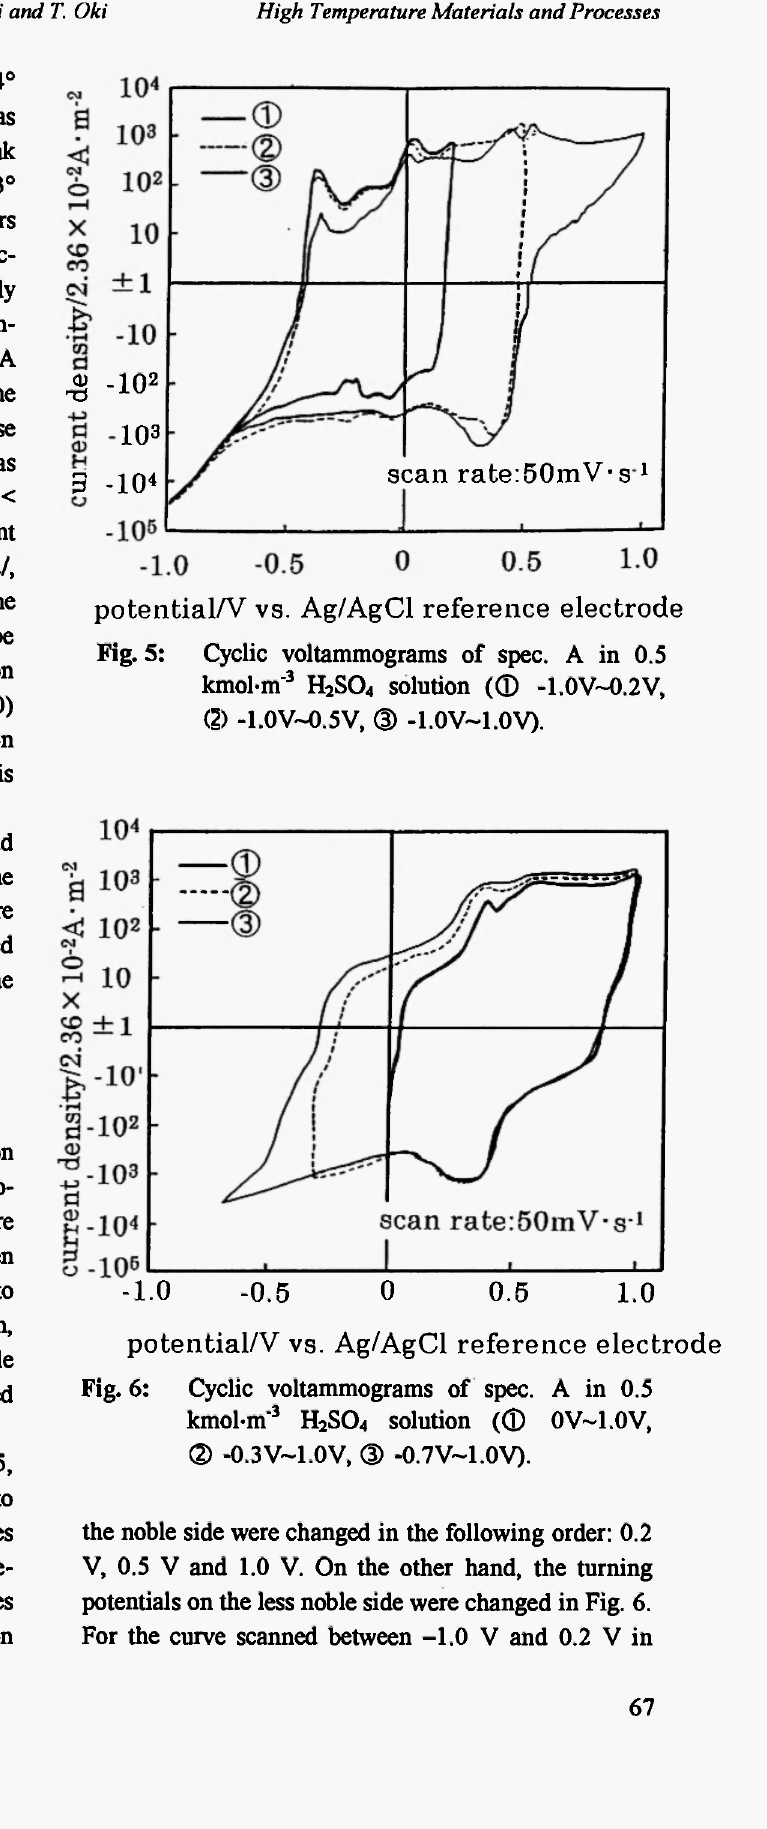
potential/V vs. Ag/AgCl reference Fig. 5: Cyclic voltammograms of spec. A in 0.5 kmol-m" 3 H S0 solution (φ -1.0V~0.2V, 2 4